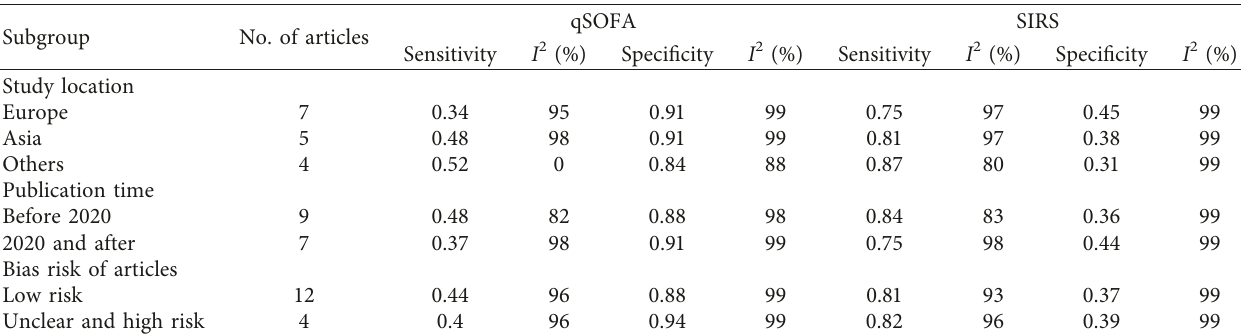
qSOFA, quick sequential organ failure assessment; SIRS, systemic inflammatory response